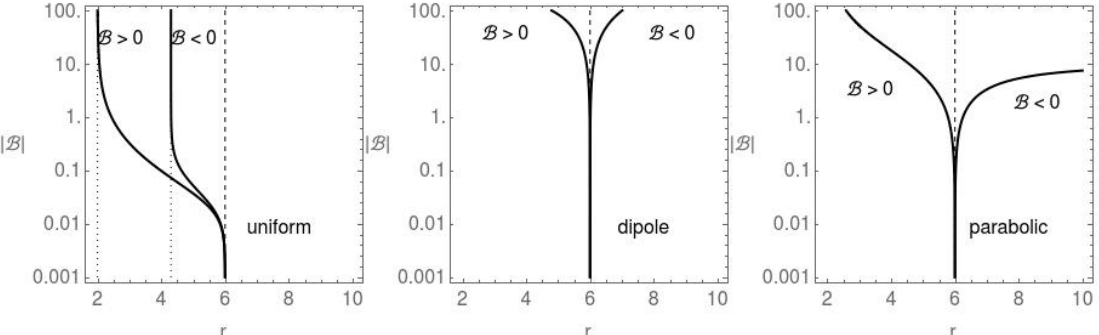
Figure 5. The radii of the charged particle ISCO in dependence on the magnetic field parameters B , K are given for the uniform dipole and parabolic magnetic fields. Repulsive Lorentz force B > 0/ attractive Lorentz force B < 0. Notice the special character of the uniform field case. caused by the fact that the electromagnetic interaction parameter remains independent of the radius, only the velocity of the motion is